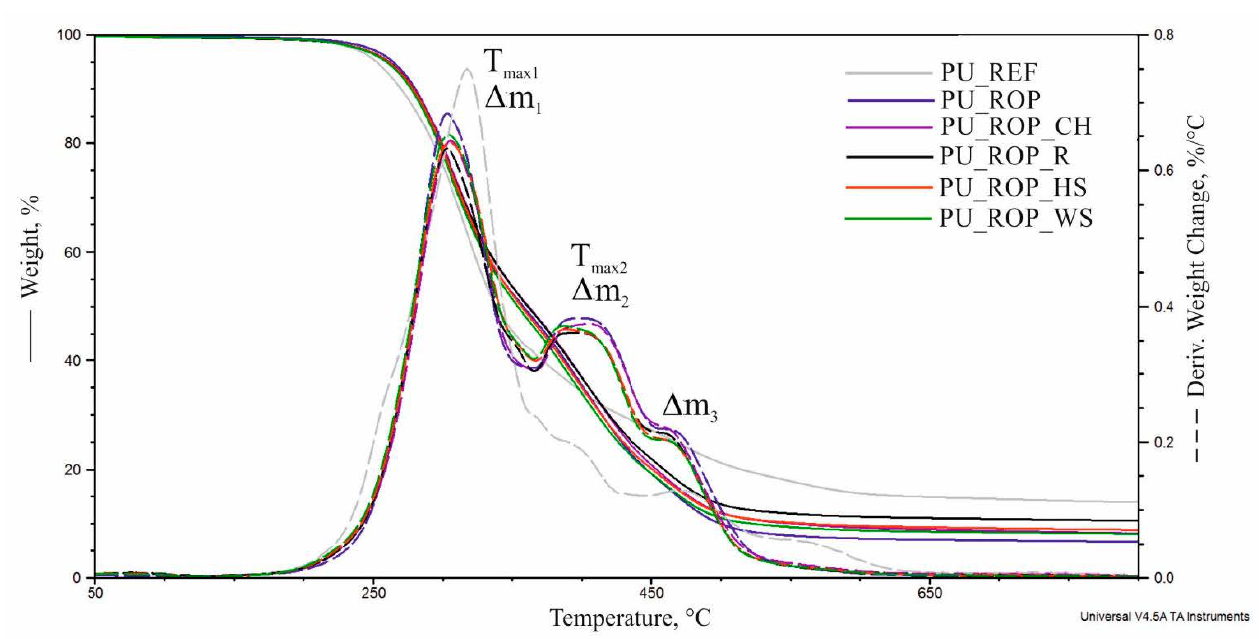
Figure 11. TG and DTG thermograms of